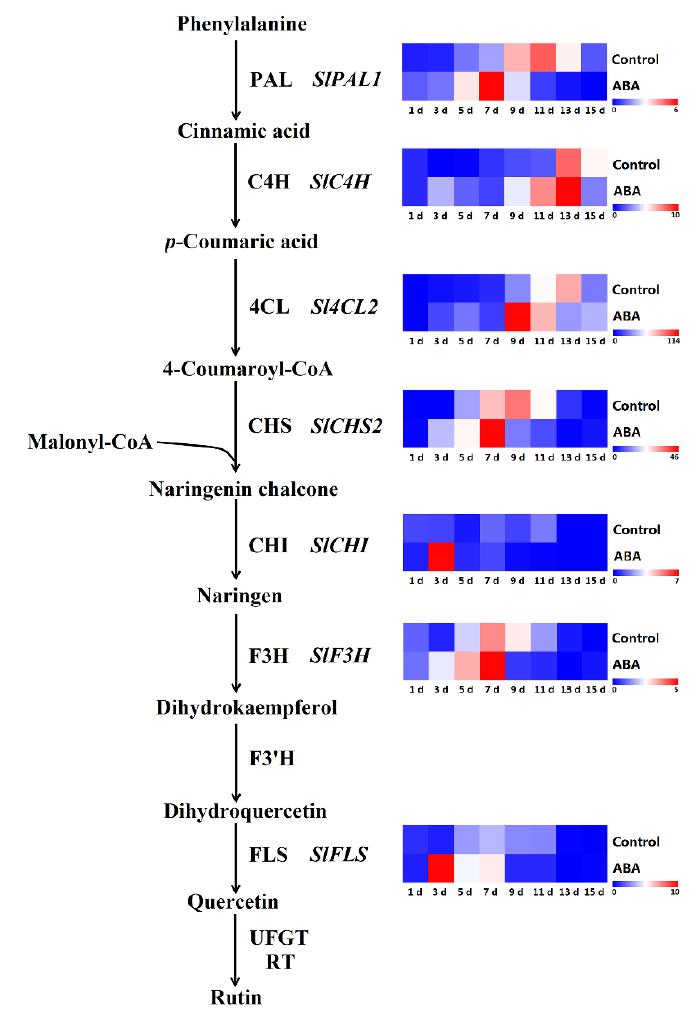
Figure 10. Schematic diagram of the phenylpropanoid pathway and the expression of partial genes involved in this pathway. The control treatment was used as a reference sample for gene expression analysis, calculated based on the 2 − ∆∆ Ct method. The results are shown in the heatmap. The red and blue colours represent the maximum and minimum expression levels, respectively. Enzyme names